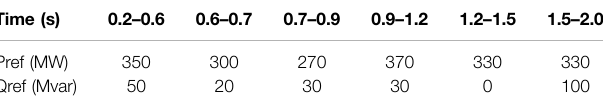
TABLE 2 | Power references in different time period.